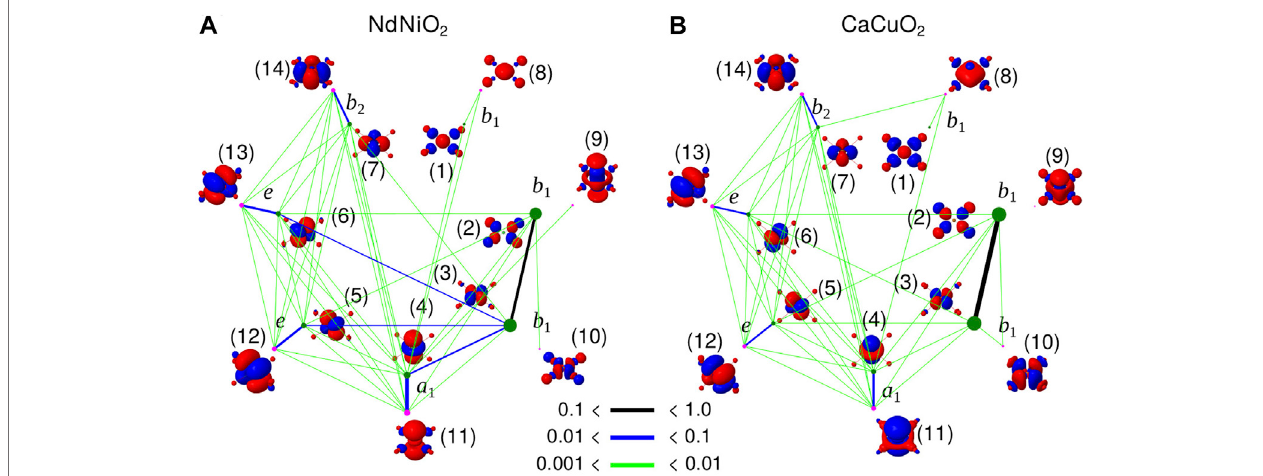
FIGURE 4 | Single orbital entanglement entropy, s(i) i (dots) and mutual orbital entanglement entropy, I i , j (colored lines) of the orbital basis used to expand the d 8 wavefunction in Table 3 for NdNiO 2 (A) and CaCuO 2 (B) . Entanglement entropy of the orbitals centred on the central NiO 4 /CuO 4 plaque are only shown. The irrep to which the orbitals belong to are also shown. The green and magenta colors represent the two different set of orbitals, occupied (at the HF level) and the corresponding double-shell(virtual), respectively.Thethicknessoftheblack, blueandgreenlinesdenotethestrengthof I i , j ,andthesizeofthedotsisproportionalto s (1) i .Theraw data is presented in Supplementary Tables S1, S2